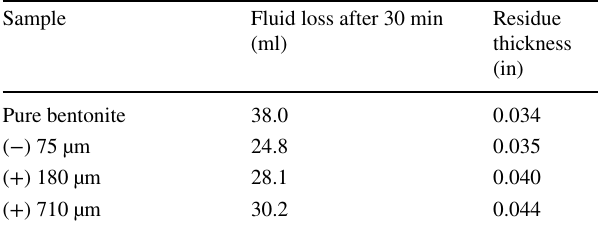
Table 6 Effect of size on filtration properties Sample